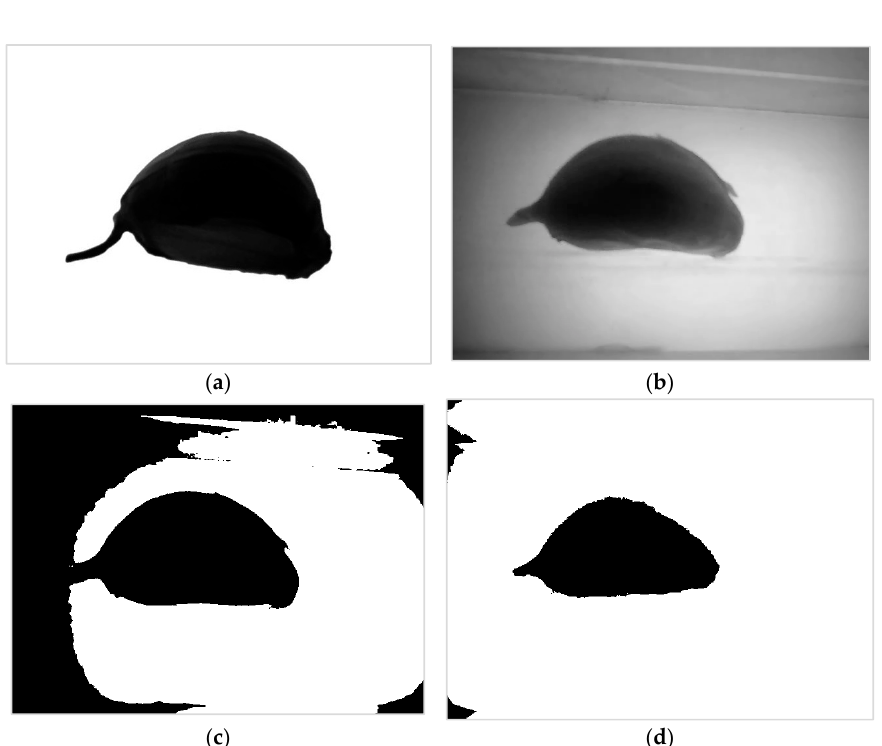
Figure 2. The lighting environment in the device affects shadow imaging. ( a ) Idealized shadow image, ( b ) Actual shadow image, ( c ) Otsu-based binary image, ( d ) Fixed-threshold-based binary image.